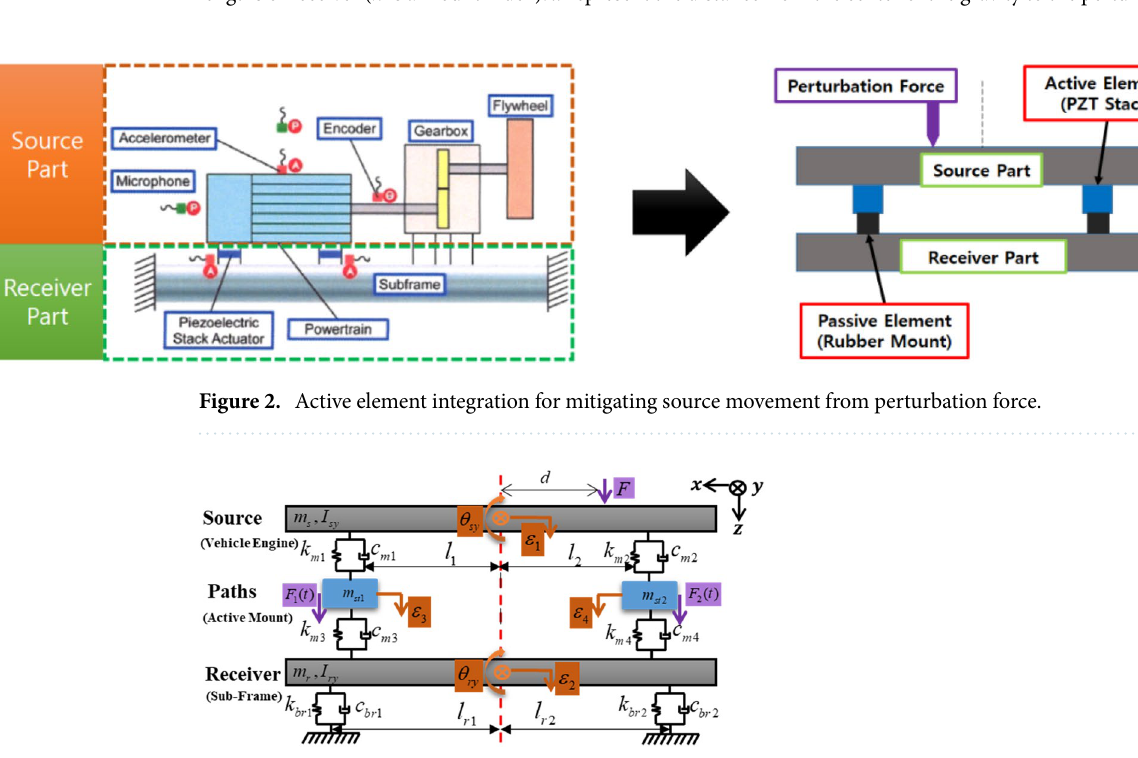
Figure 3. 6-DOF lumped parameter model of given source-path-receiver